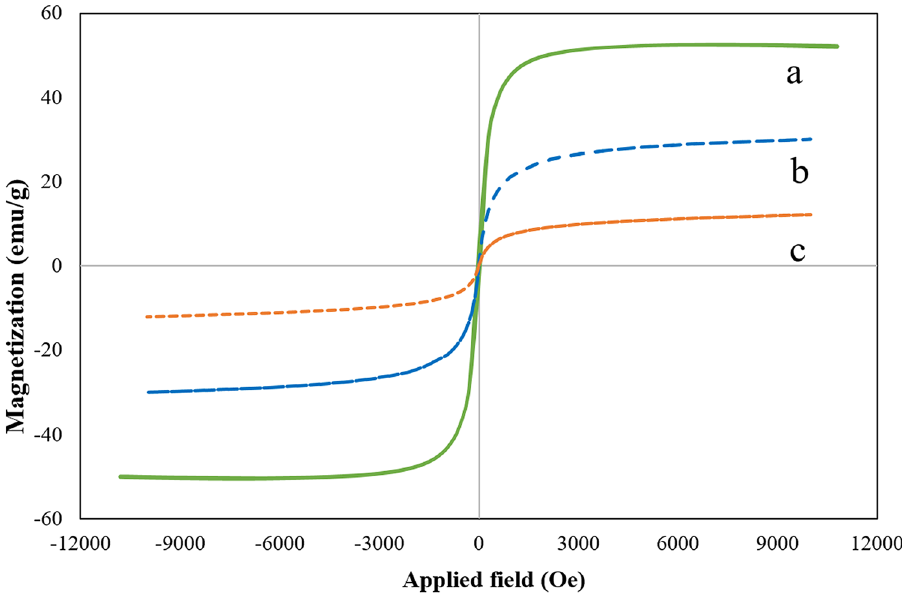
Figure 5. The magnetization curves of ( a ) Fe 3 O 4 MNPs, ( b ) SBA-15/Fe 3 O 4 , ( c ) and the guanidinylated SBA-15/